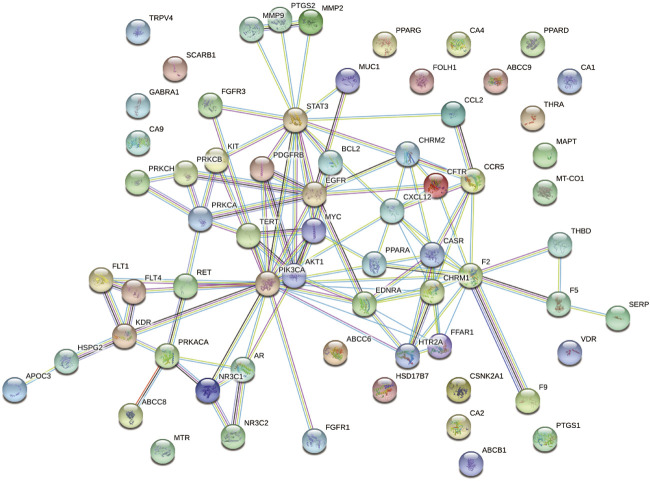
A PPI network of the targets of vitamin C with therapeutic potential for CVD was generated. A PPI network of 66 targets was imported into STRING database and visualized with the interaction score set to the highest confidence (0.900).